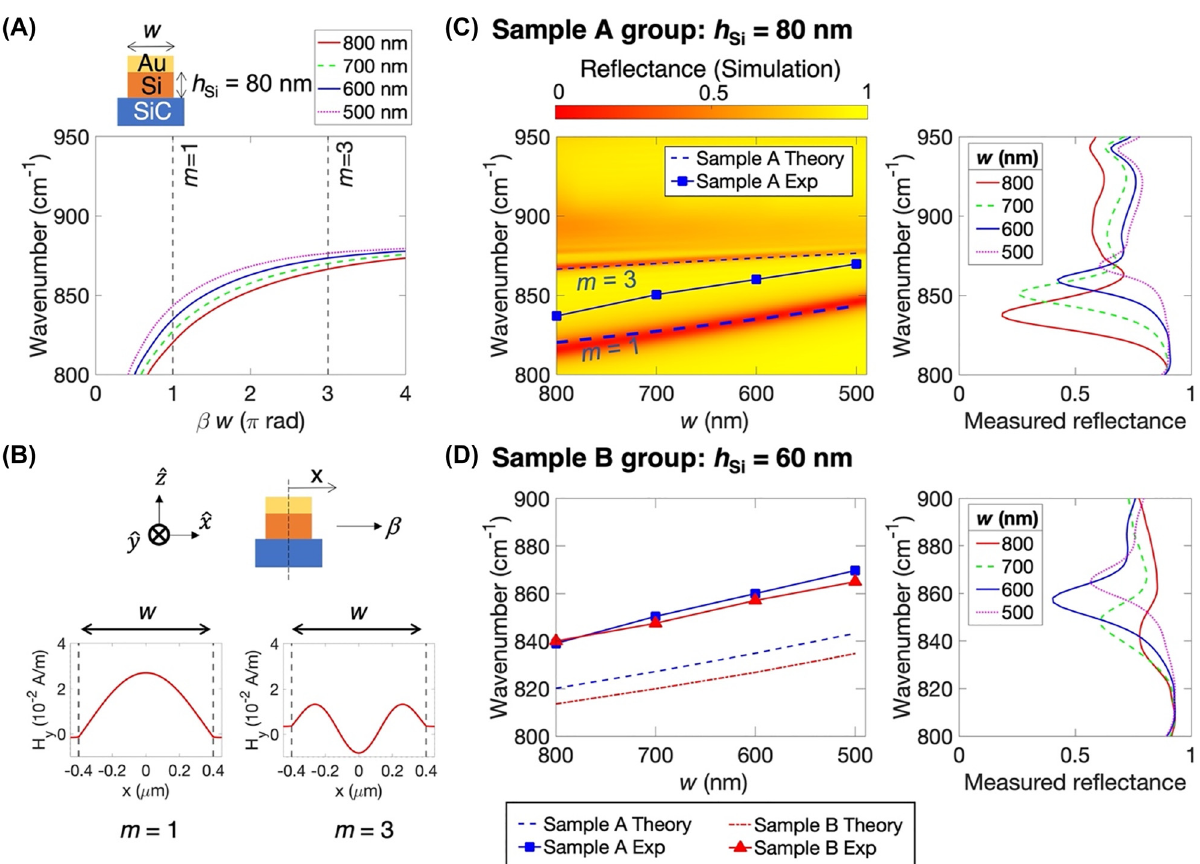
Figure 2: Spectral tunability of the coupled SPP–SPhP cavity resonance. All samples have the same 40 nm thick Au and a 900 nm grating and cavity length w . (A) Fabry–Pérot resonance condition of the coupled SPP–SPhP modes with respect period, but different Si thickness h Si = 80 nm. The resonance frequency is determined when the propagation phase 𝛽 w is odd to four different cavity lengths w when h Si multiples m = 1, 3, . . . of 𝜋 . The propagation constant 𝛽 is given in Figure 1(C). The resonance frequency has a monotonic blue shift when were obtained by full-wave simulation when w = 800 nm at the cavity length is small. (B) Standing waves of the transverse magnetic field H y = 80 nm. for m = 1 and f for m = 3. (C) Measured and simulated reflectance of sample A group which has h two resonance frequencies f 1 3 Si Left: color map shows reflectance given by full-wave simulation with respect to frequency and cavity length. Two dark and light red line and f obtained fringes at the color map present enhanced absorptions due to the cavity resonance. The dashed blue line indicates f 1 3 determined by measured reflectance under the normal incidence. The resonance f from analytically shown in (A). The blue squares show f 1 1 the measured reflectance is consistently shifted about 20 cm − 1 from the estimated f analytically and numerically. Right: measured 1 = 60 nm. Left: dot-dashed red line indicates f of sample B obtained reflectance of sample A group. (D) Sample B group, which has h Si 1 of sample A shown in (C). The red triangles show f of sample B given by measured reflectance compared with f analytically compared with f 1 1 1 of sample A from the measurement shown in (C). Right: measured reflectance of the sample B